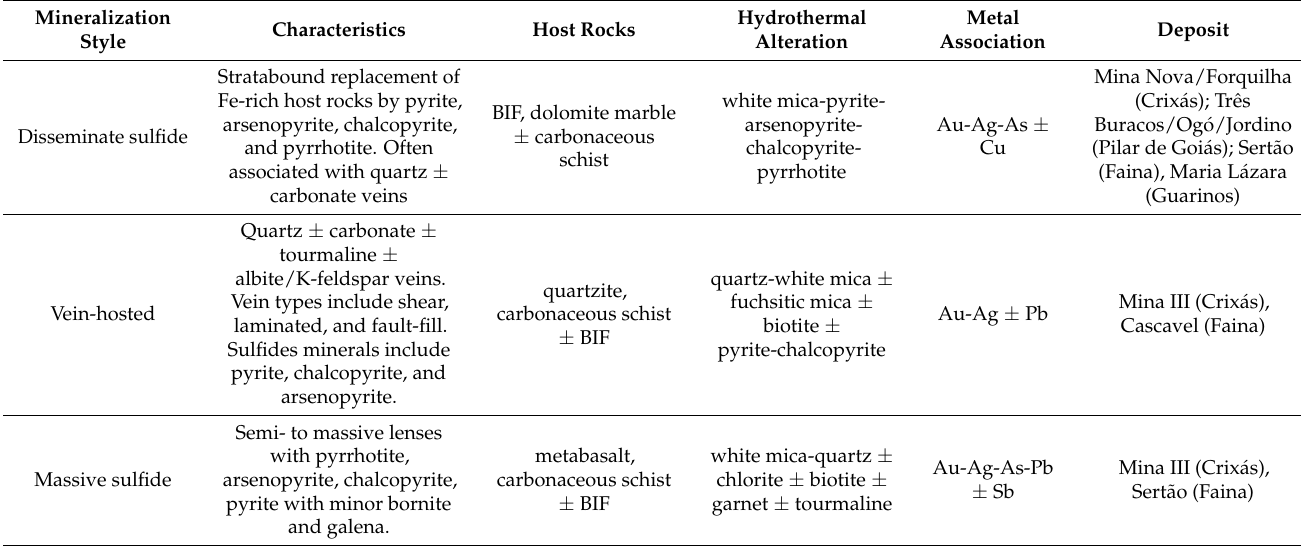
Table 4. Mineralization styles of orogenic gold deposits in the